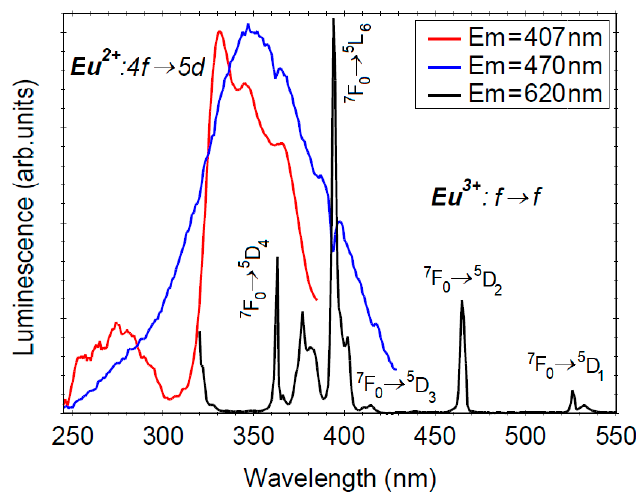
Figure 6. Photoluminescence excitation spectra recorded on the Eu-doped chloroborate glass-ceramic after annealing at 570 °C in a reducing atmosphere (H 2 –Ar).